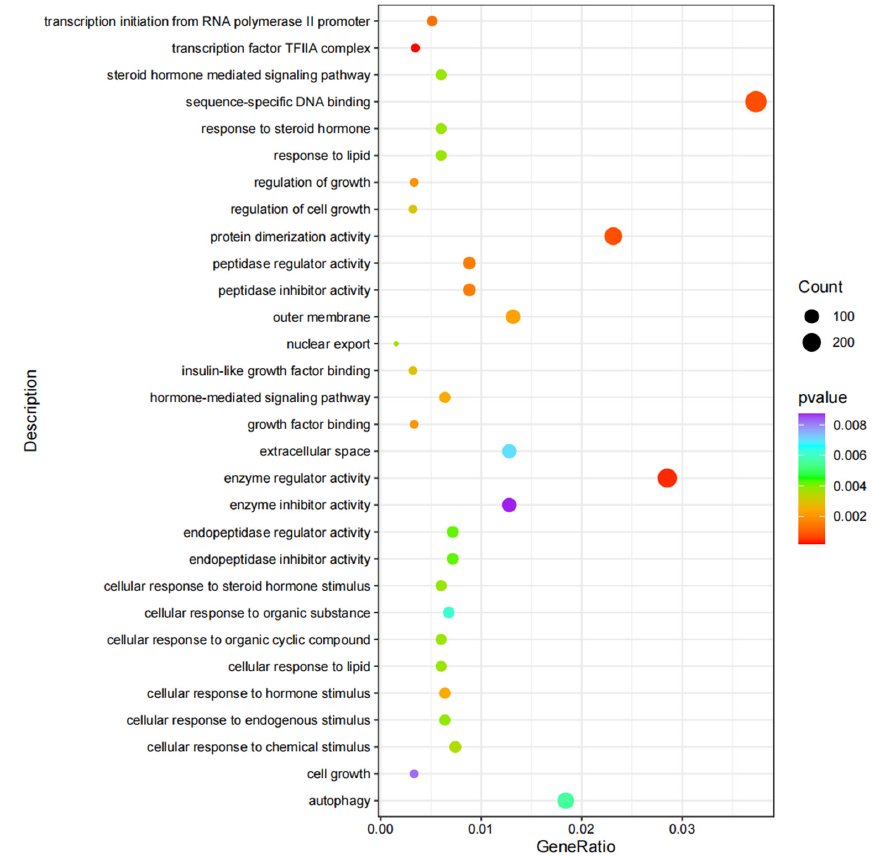
Figure 4. GO enrichment analyses of the differentially expressed miRNA target genes.